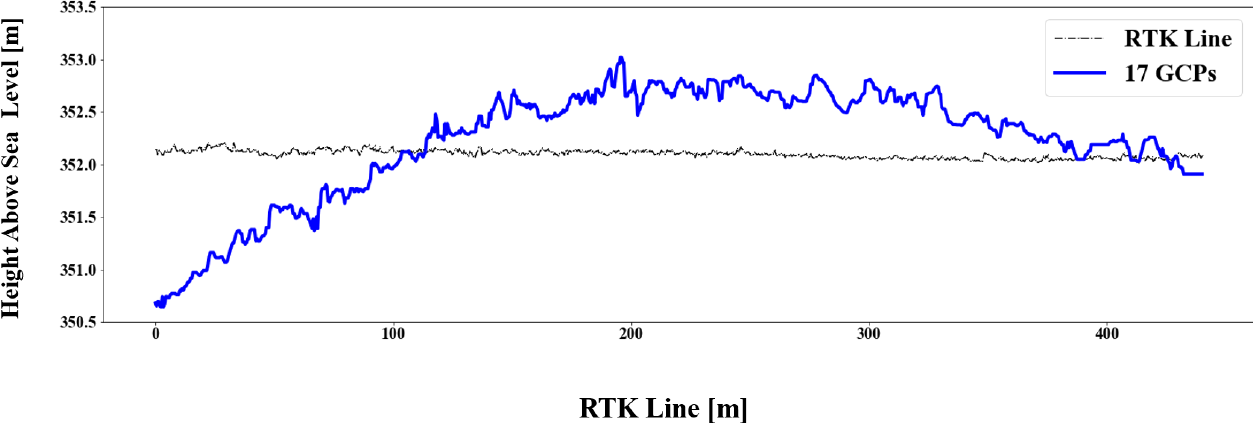
Figure 11. The doming effect visualised through comparison of elevation levels extracted from the RTK line vs. elevation values extracted from the reconstructed photogrammetry-based point cloud.